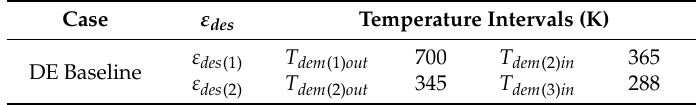
Table 2. Un-Utilized Temperature Intervals between Demanded Applications.